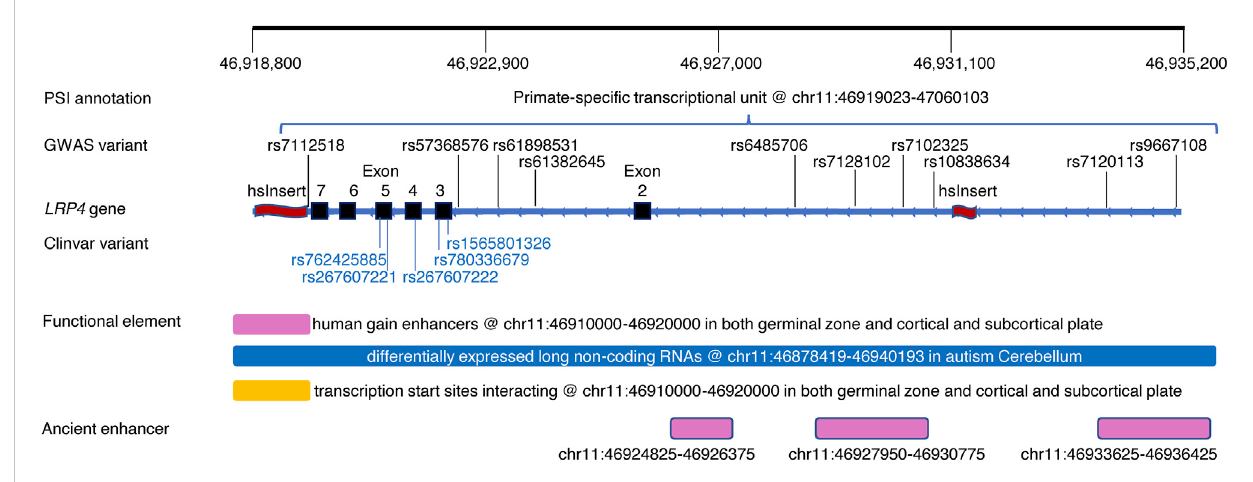
FIGURE 2 An exemplar region within the LRP4 gene harboring common and rare pathogenic variants, PSI and other regulatory elements. Top track: Genomic positions of the region of interest; PSI annotation track: Alignment of a PSI element; GWAS variants track: Alignment of genome-wide signi fi cant variants associated with Schizophrenia and/or body mass index (Supplementary Tables S2, S3); LRP4 gene track: Refseq gene LRP4 marked with exons (black rectangle) andtwohuman-speci fi cinsertions(redwave) within theregion ofinterest; Clinvarvariant track: Alignment ofClinvar pathogenic variants causing Cenani-Lenz syndactyly syndrome (https://www.ncbi.nlm.nih.gov/clinvar/); Functional element track: Alignment of human gain enhancer (Won et al., 2019), long non-coding RNA (Parikshak et al., 2016), interacting transcription start starts (Won et al., 2019); Ancient enhancer track: Alignment of ancient enhancers in neocortex shared across mammals (Emera et al.,